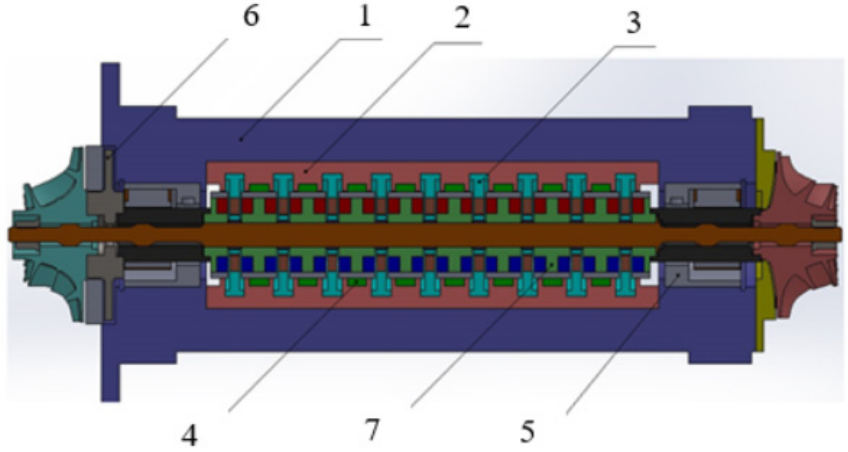
Figure 13. Cross section of the axial generator with an indication of the location of the main structural elements. 1—ed, 2—stator cassette, 3—armature winding, 4—radial gas-dynamic bearing, 5—radial active magnetic bearing, 6—axial gas-dynamic bearing, 7—inductor.